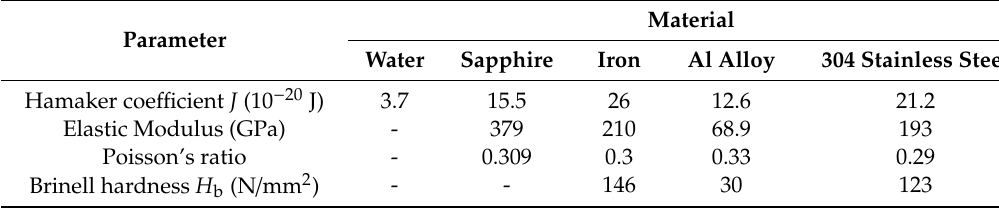
Table 2. Physical properties of di ff erent